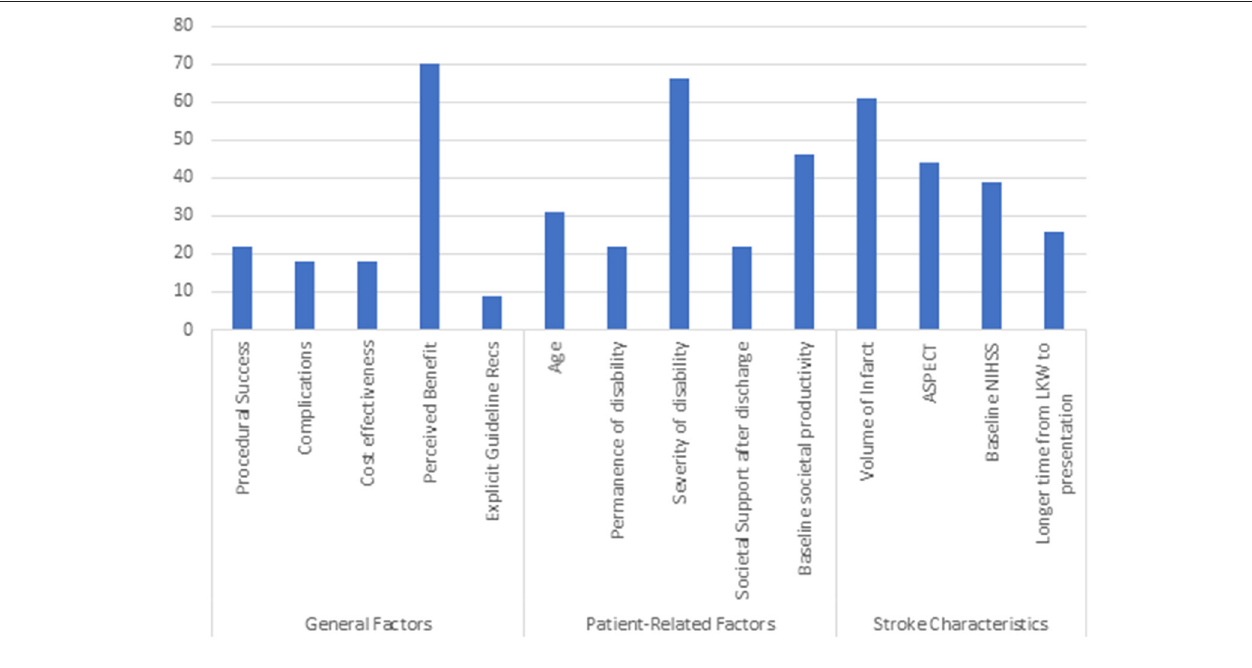
FIGURE 2 | Factors affecting EVT